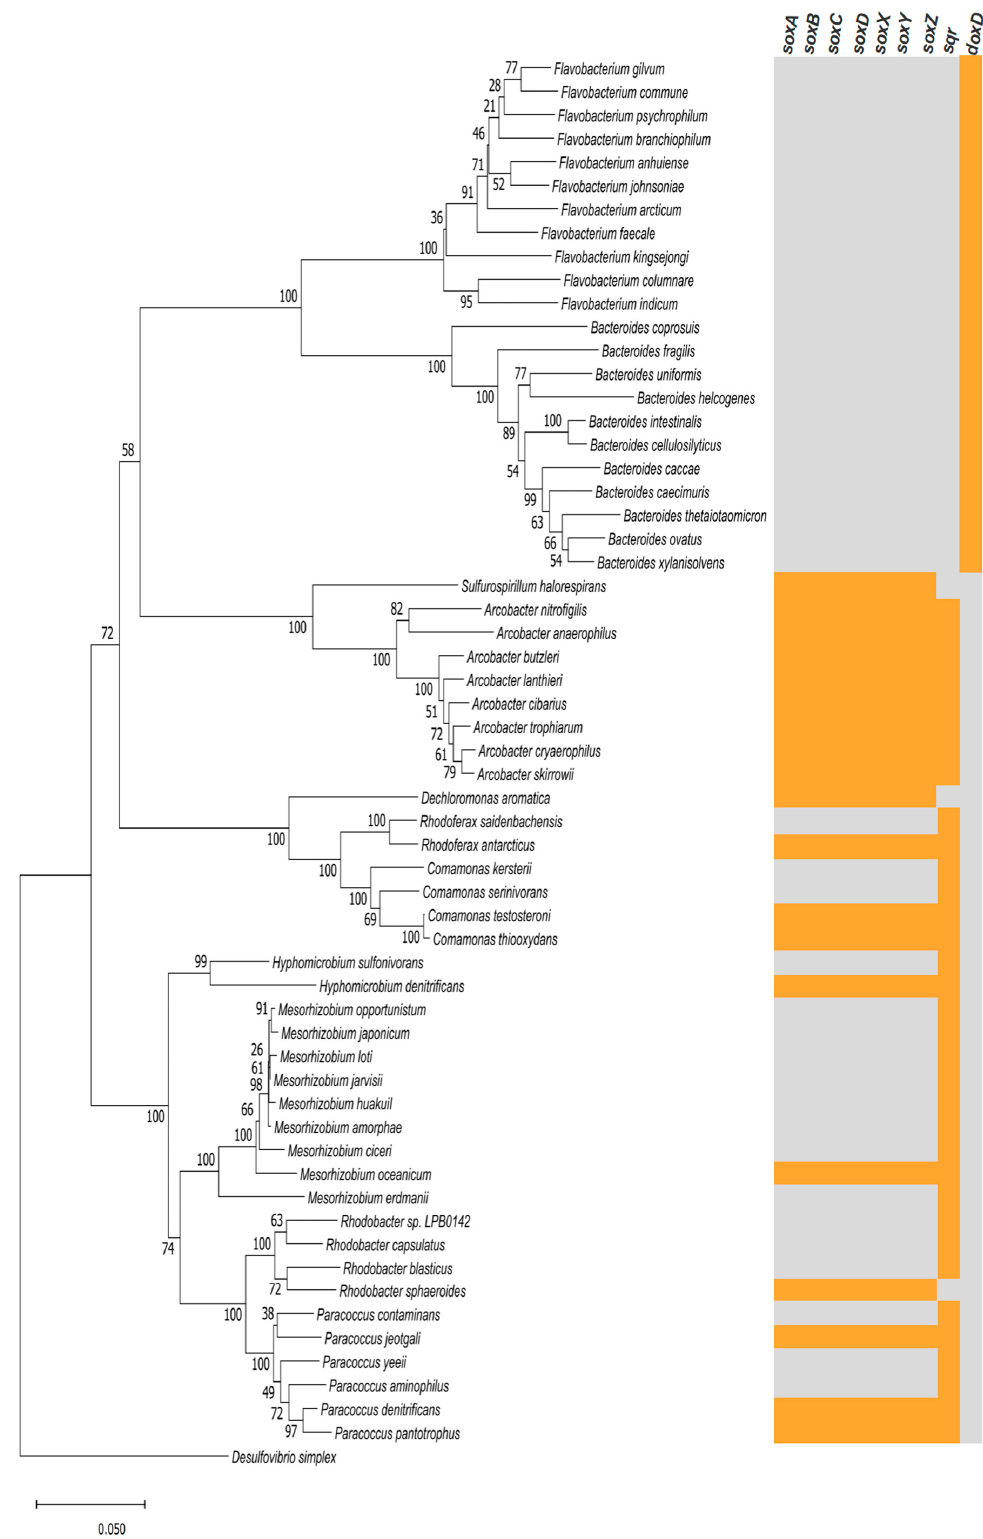
Figure 3. Phylogenetic tree of SOB at species level harboring thiosulfate-oxidation related genes, including soxA , soxB , soxC , soxX , soxY , soxZ , sqr , and doxD . Orange labeled grids represent the genes positively present, while gray labeled grids represent the genes negatively present. The evolutionary history displayed on tree was inferred using the Neighbor-Joining method. The percentage of replicate trees in which the associated taxa clustered together in the bootstrap test (500 replicates) are shown next to the